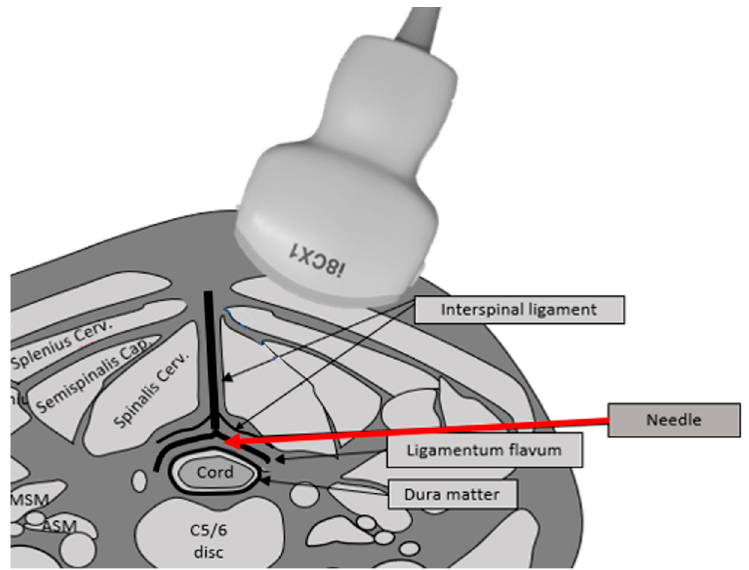
Figure 1. The illustration shows the needle insertion route on the cross-sectional image of the neck. The main structures are the cord, dura mater, interspinous ligament, and ligamentum flavum. The epidural space exists between the dura mater and the ligamentum flavum. The needle (red arrow) is introduced tangentially in between the ligamentum flavum and dura matter.